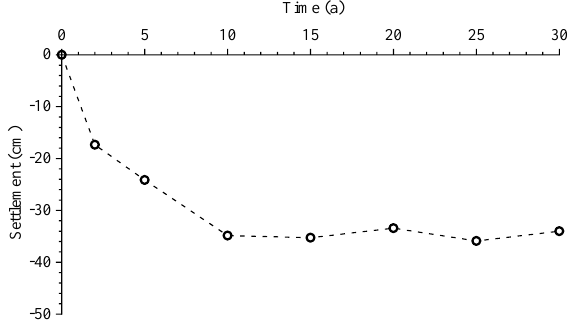
Figure 8. Development of vertical settlement of the pipeline over the simulation period. The vertical stress distribution of the pipeline at different times after pipeline com- pletion is shown in Figure 9. Oval-shaped high-stress areas were created on the top